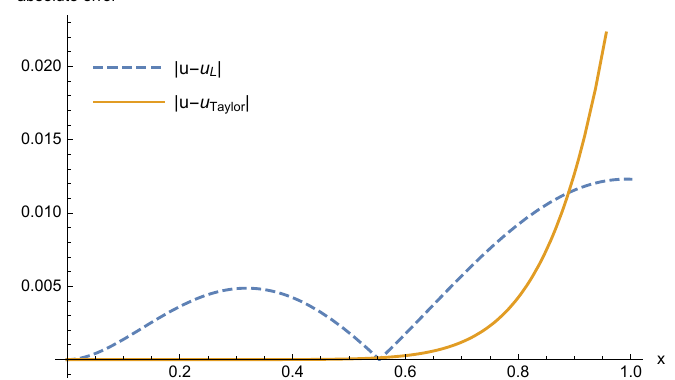
Figure 1. The absolute error between exact solution and u L and u Taylor .